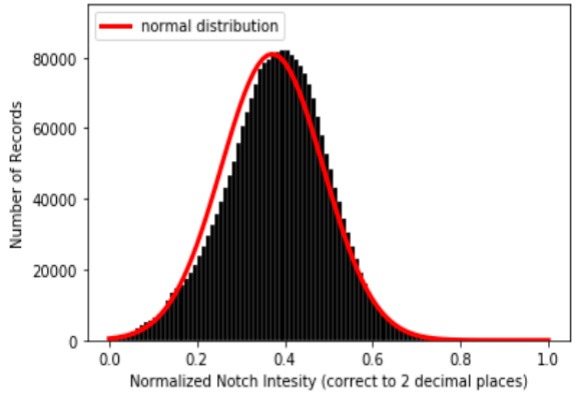
Figure 8. Distribution of normalized notch intensity.